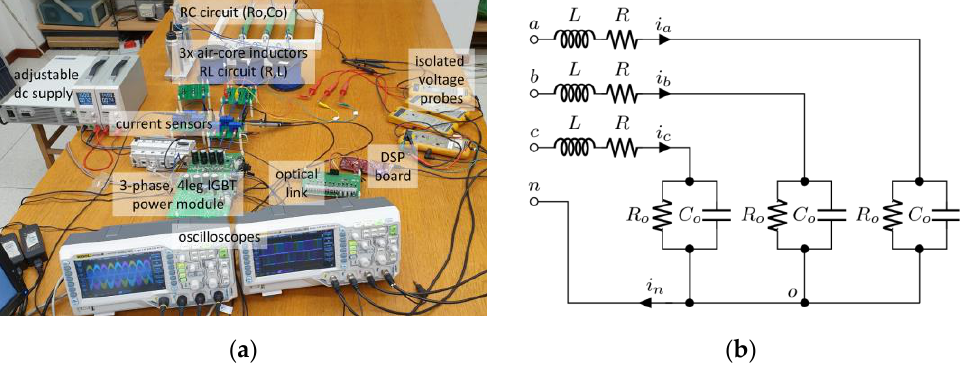
Figure 32. ( a ) Experimental laboratory workbench; ( b ) Unitary power factor load.